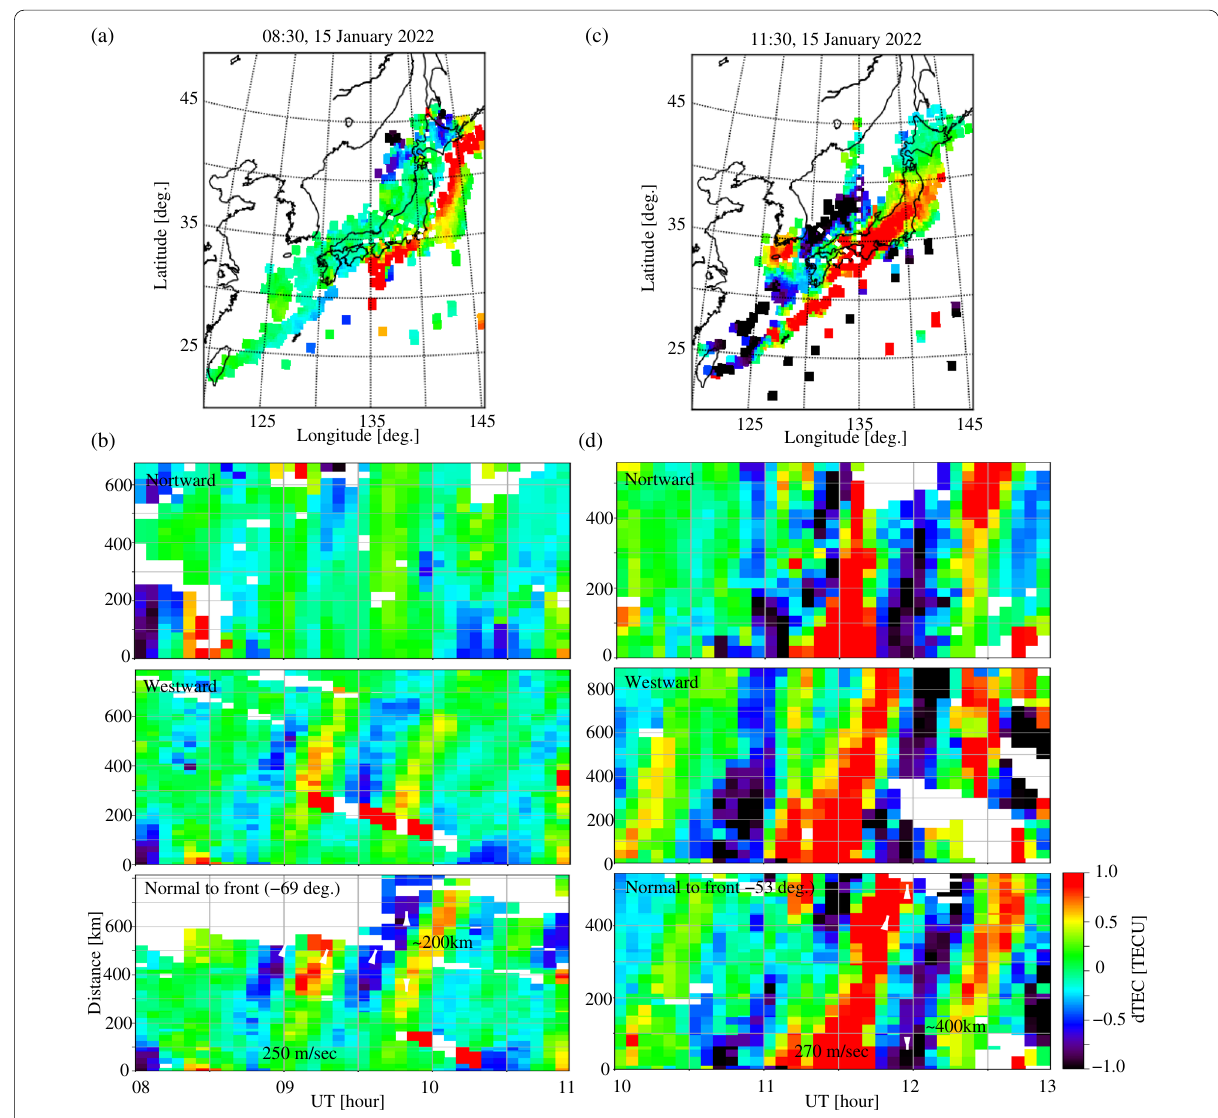
Fig. 3 a Perturbation component of TEC (dTEC) at 0830 UT (1730 JST) on 15 January 2022. b Keograms of dTEC along the white dashed lines in a , northward and westward directions, and the direction of the velocity from (37 ◦ N, 142 ◦ E). c dTEC at 1130 UT (2030 JST) on 15 January 2022. d Keograms of dTEC along the white dashed lines in c , northward and westward directions, and the direction of the velocity from (33 ◦ N, 137 ◦